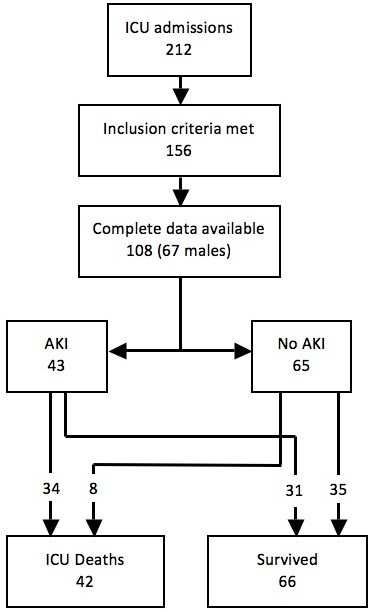
Flowchart of patients recruited to study.